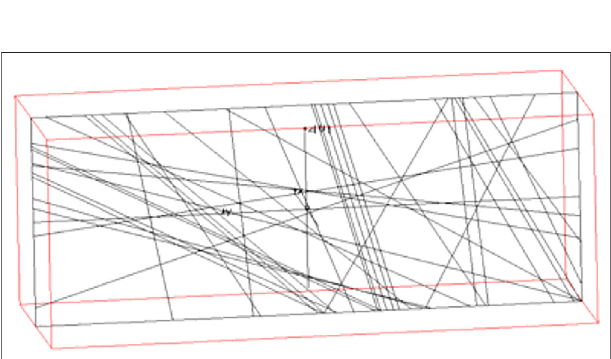
FIGURE 14 | The display of the cross-section.